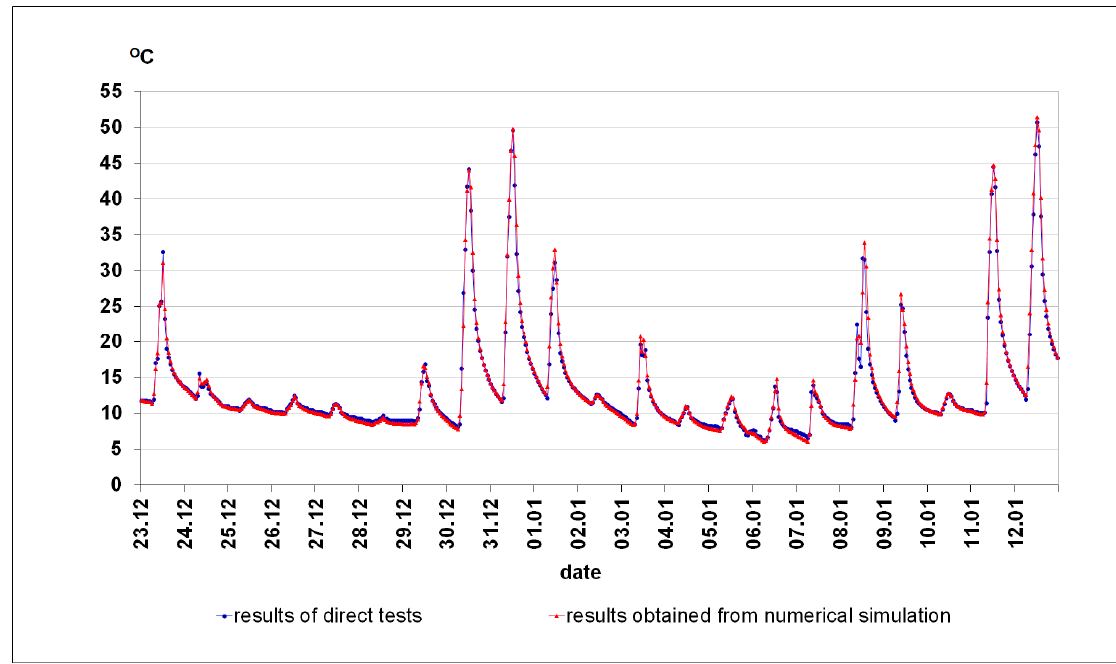
Figure 19. Graph of temperature of the absorber based on direct tests and numerical simulations.